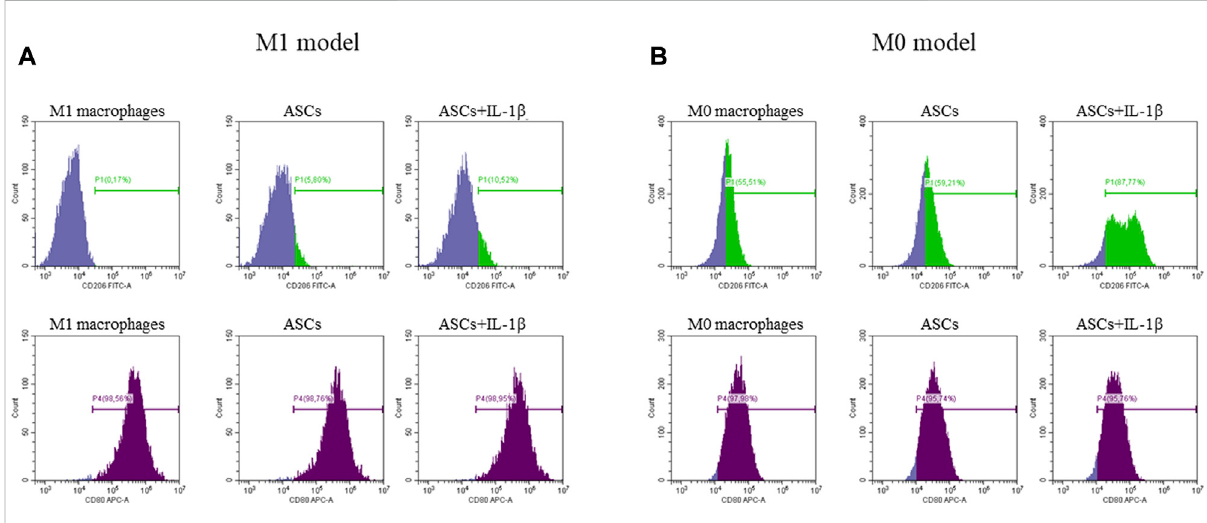
FIGURE 4 Expression of anti-in fl ammatory (CD206, green) and pro-in fl ammatory (CD80, purple) markers by M1 (A) and M0 (B) macrophages after co- culture with ASCs primed or non-primed with IL-1 β . The percentage of positive cells is indicated on each single